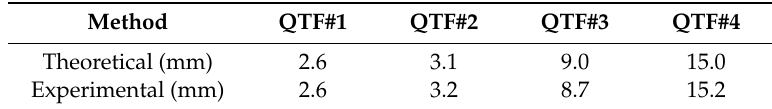
Table 3. Comparison of theoretical estimation of optimum laser position given by the numerical model reported in Reference [7] and results obtained experimentally.